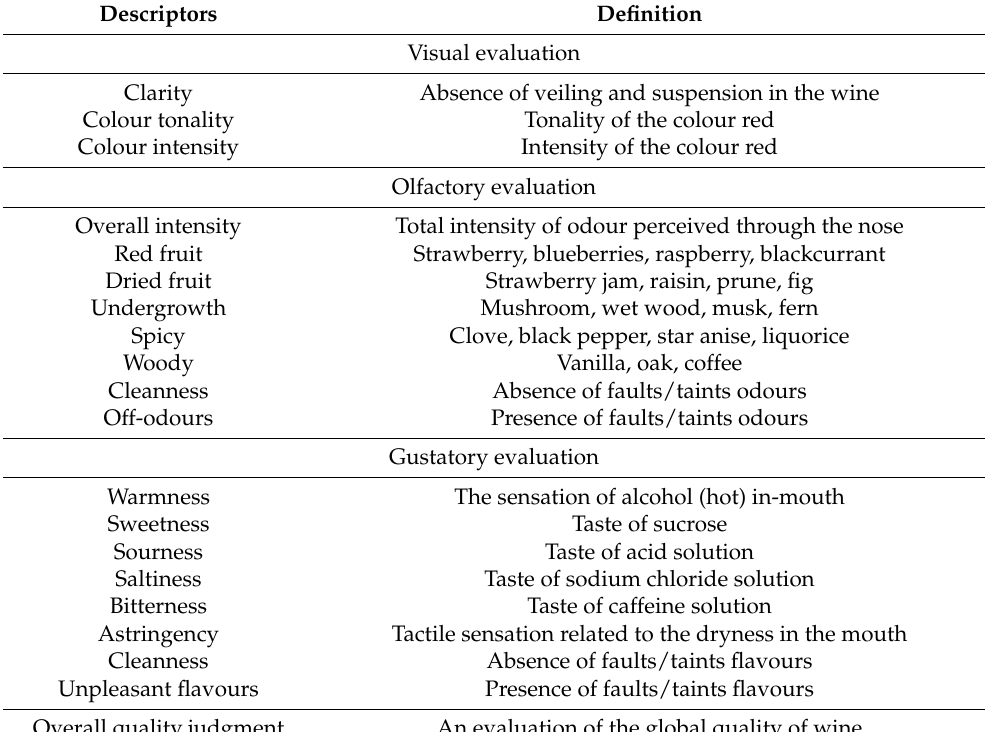
Table 1. List of descriptors and definitions used in the sensory